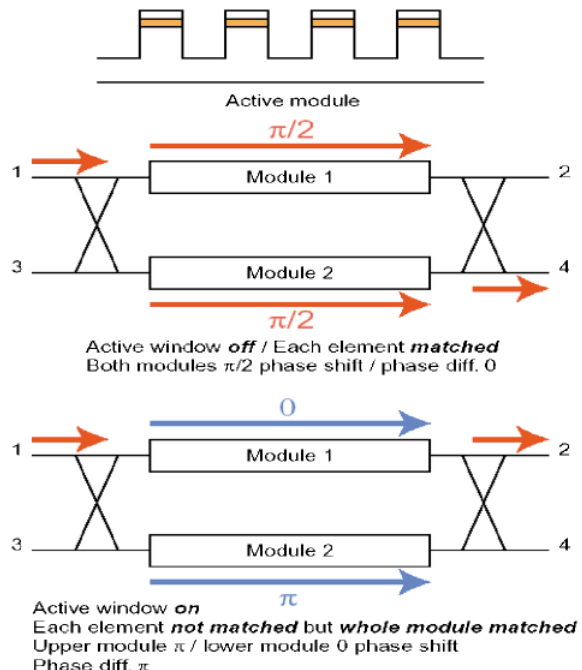
FIG. 3. (Color) Operating principle of cascaded phase shifter.